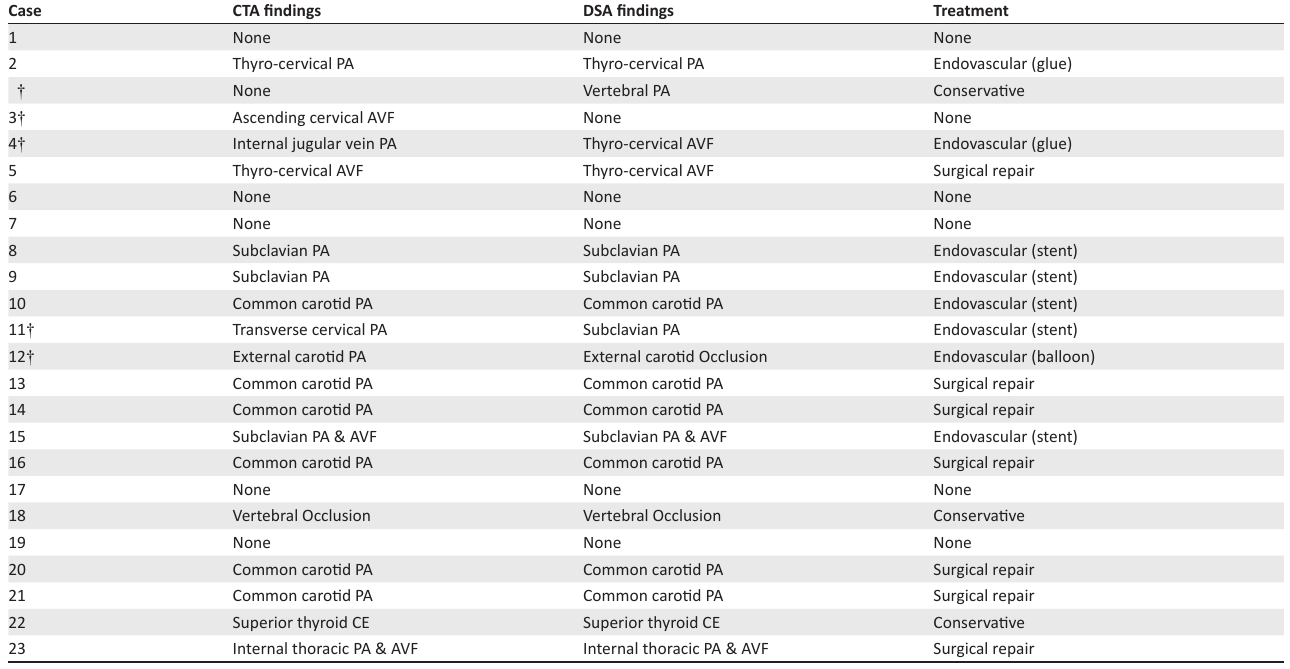
FIGURE 2: Clinical signs and corresponding injuries detected on digital subtraction angiography. TABLE 1: Table showing CTA and DSA findings and subsequent